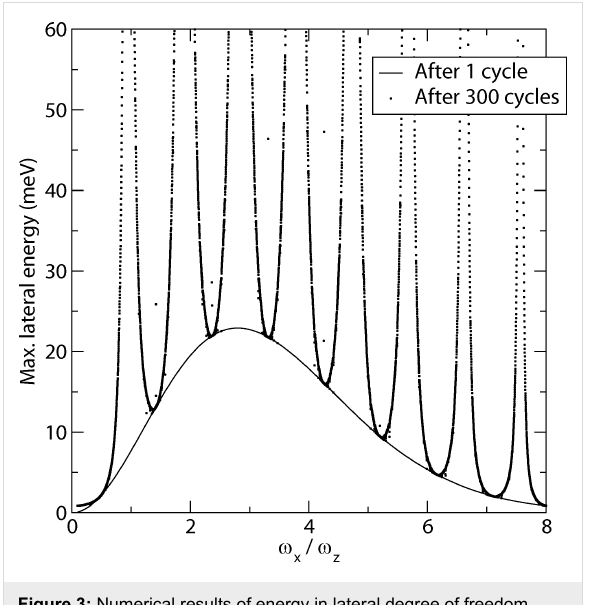
Figure 3: Numerical results of energy in lateral degree of freedom after one cycle (line) and maximum energy in the lateral degree of freedom ( ) over 300 cycles (points) versus frequency ratio ω x / ω z